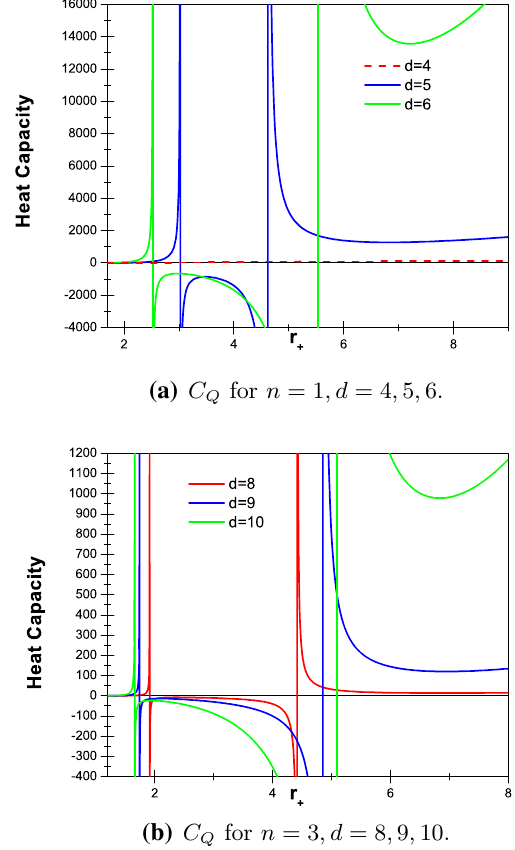
Fig. 5 C Q . a Represents both families of solutions, and b represents to the first family of solutions, both with toy values of Q = 1 and l =